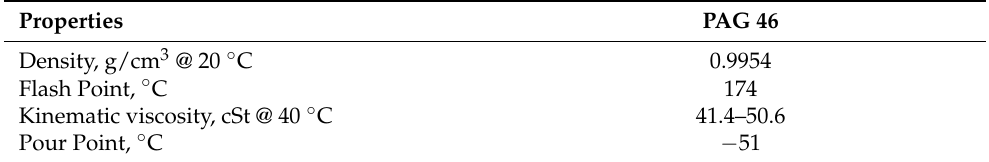
Table 2. Properties of the PAG 46 lubricant at atmospheric pressure